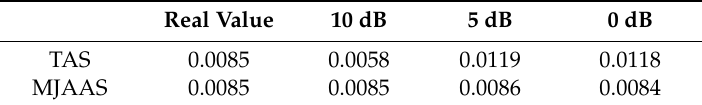
Table 5. The estimated results of ω e (rad/s).